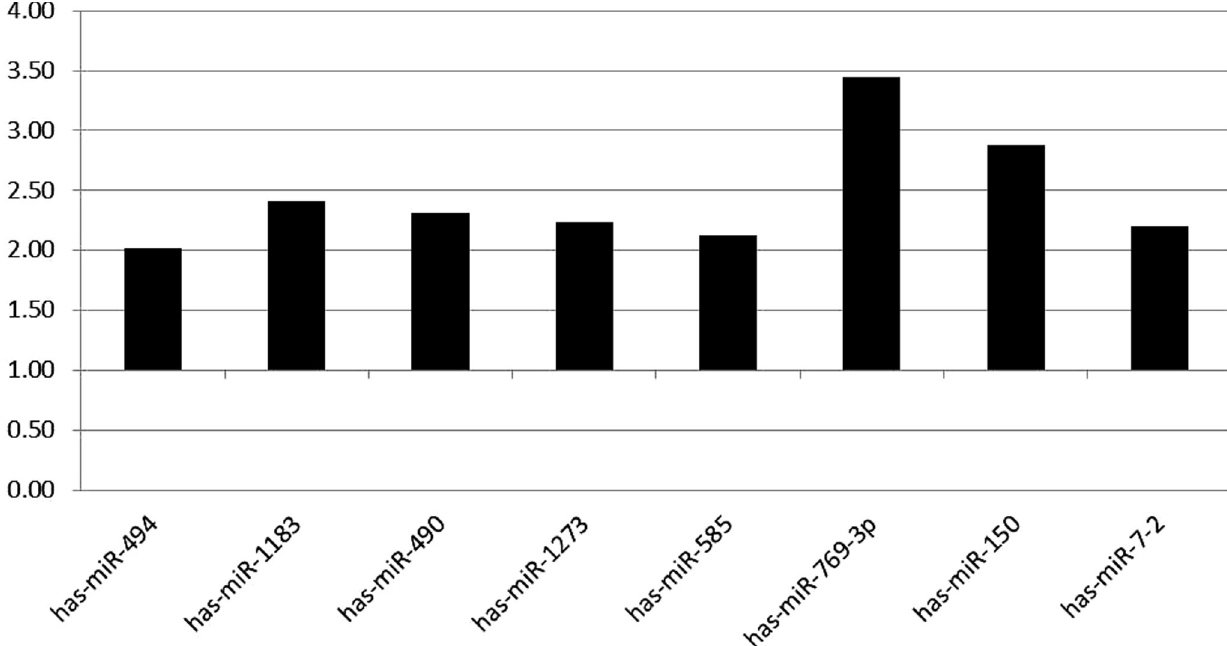
Figure 1. Fold change in plasma miRNA expression between in two groups. miRNAs shown had expression increased >2-fold between the groups; 1) ≥ 70% coronary stenosis of any coronary artery or 2) < 70 coronary stenosis.